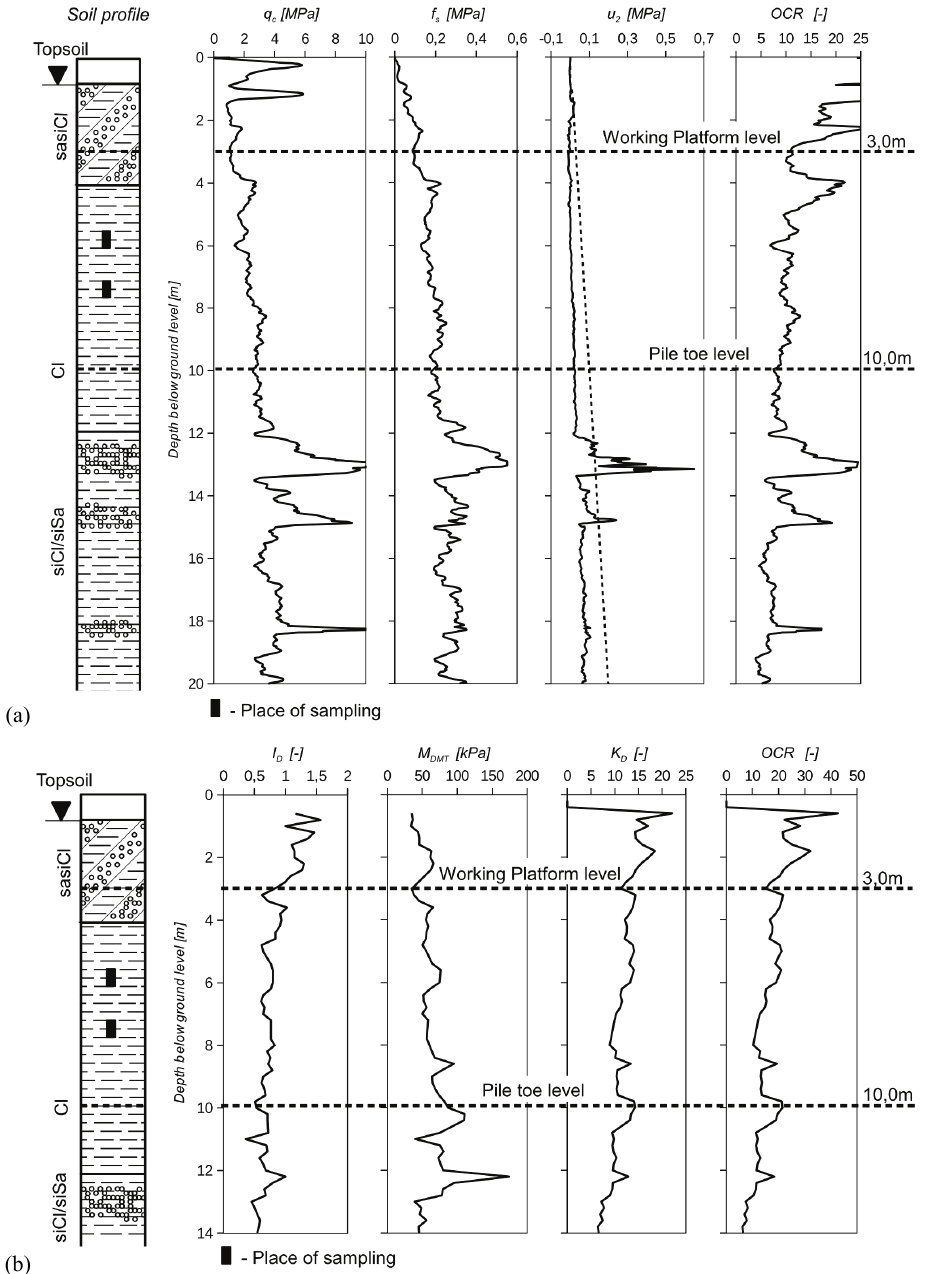
Fig. 2. (a) CPT-u 142 and (b) DMT-4 sounding